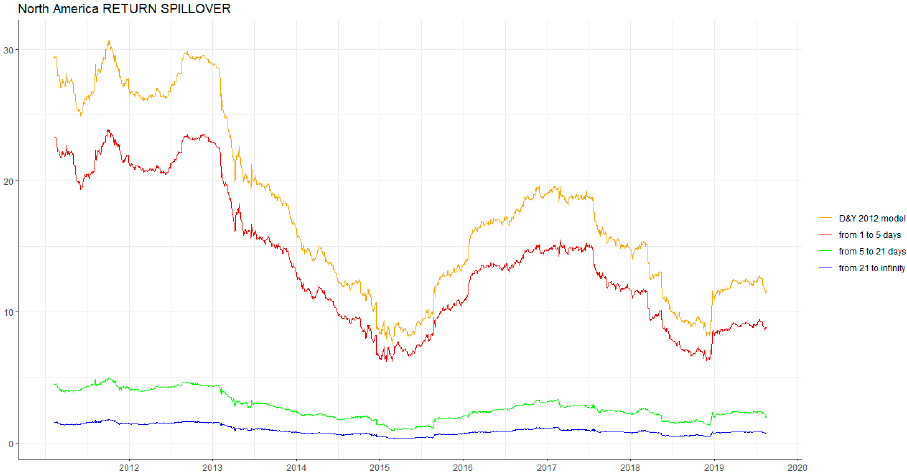
Figure A6. Total return spillover of DY12 and BK18 in North America (Windows 370).